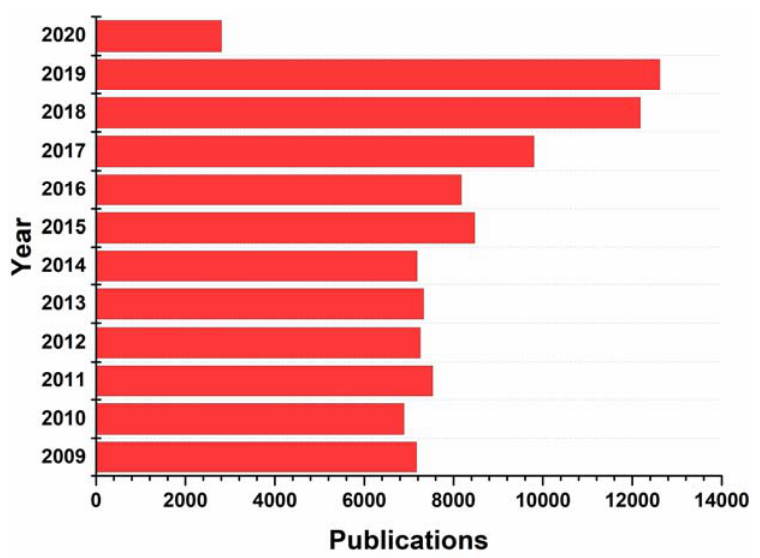
Figure 1. Publications on nitrogen-based heterocycles between 2009 to early 2020 (Source Scopus) [26].